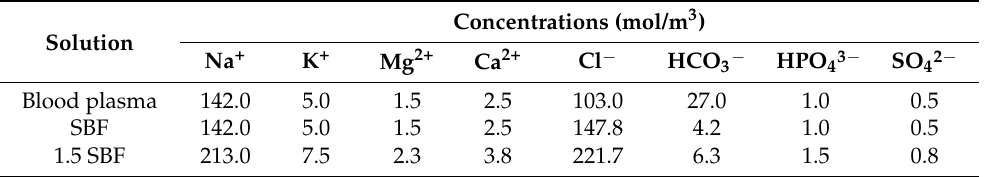
Table 1. Ionic concentration of blood plasma, 1.0 and 1.5 SBF